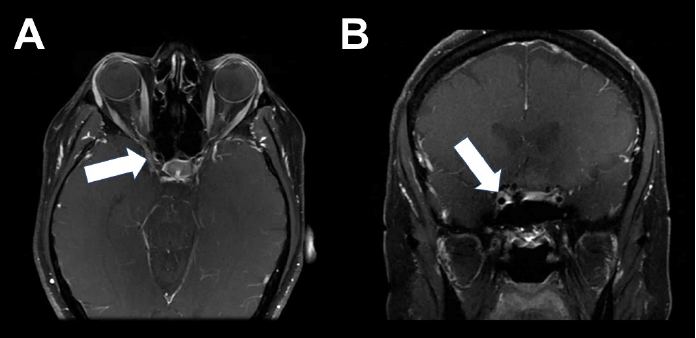
Figure 2. Post-contrast axial T1-weighted fat-saturated magnetic resonance images demonstrate an enhancing tubular structure ( A , B , arrows), with increased posterior extension into the superolateral right cavernous sinus. It courses anteriorly through the right superior orbital fissure and bifurcates in the intraconal space at the orbital apex, before terminating along the lateral aspect of the right medial rectus and superior aspect of the right inferior rectus. Findings are consistent with underly- ing infiltrative orbital metastatic disease with optic nerve involvement in the setting of known in- vasive lobular carcinoma.